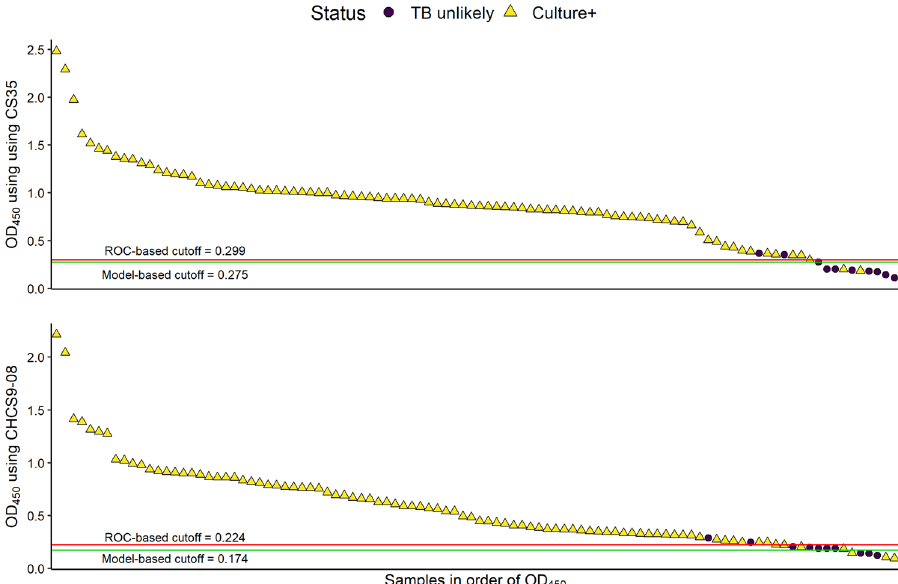
Figure 4. Comparative ELISA on follow-up cohort of 100 urine samples using two sets of antibodies. OD values for 100 samples are listed in descending order, with cutoff values for prediction shown by the horizontal lines. Points below the line were identified as negative, and above the line as positive. Yellow triangles indicate culture positive samples, black dots indicate culture negative samples. 9/100 samples were misidentified perhaps due to experimental error which were later correctly identified (Supplemental File Fig. S1) after